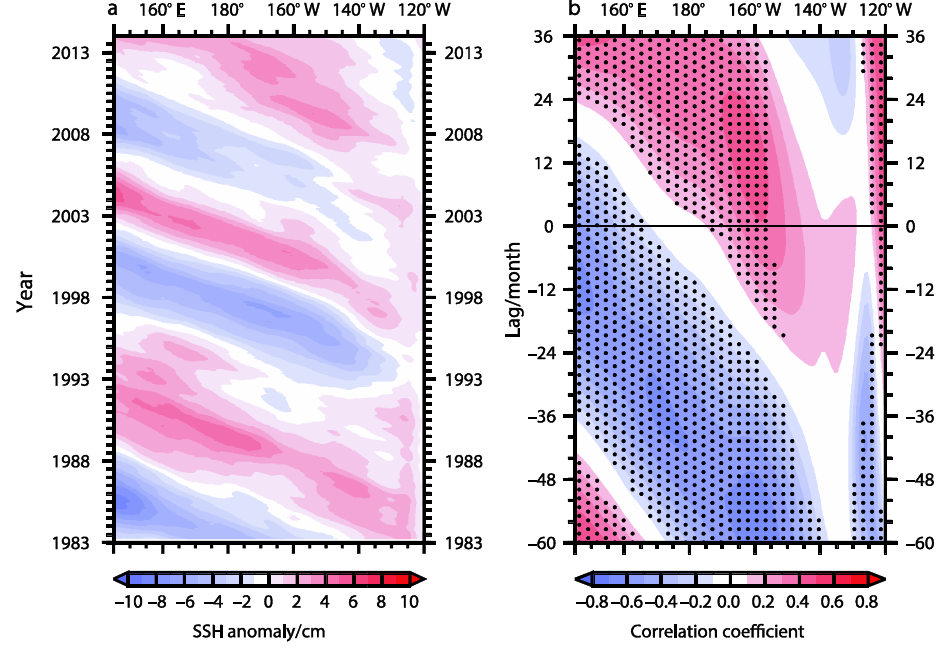
Figure 4. Same as in Figure 3, but for ( a ) the 37-month running mean SSH anomalies averaged over the 33°–35° N band from the outputs of the wind-driven Rossby wave model and for ( b ) their lead– lag correlations with the EAI.